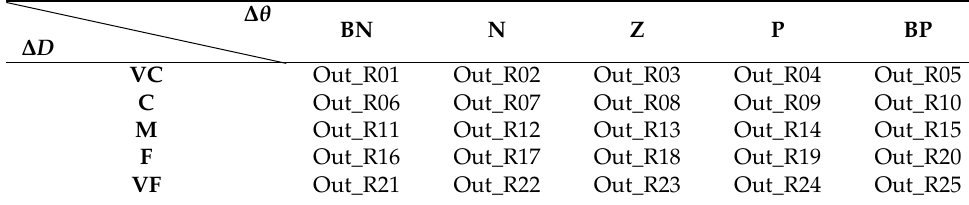
Table 4. The rules of the right wheel angular velocity.